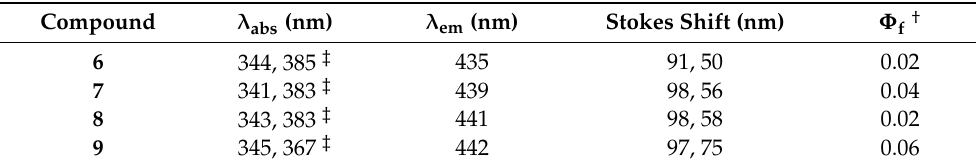
Table 1. Photophysical properties of 3-amido-1,8-naphthalimides in DMSO.